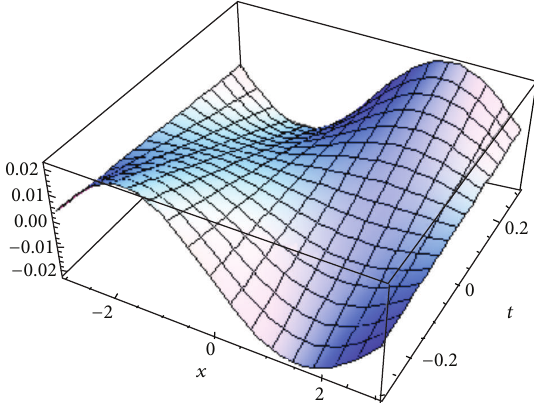
Figure 10: 2D, OHAM solution of 𝛽(𝑥,𝑡) at 𝑡 = 0.1 .